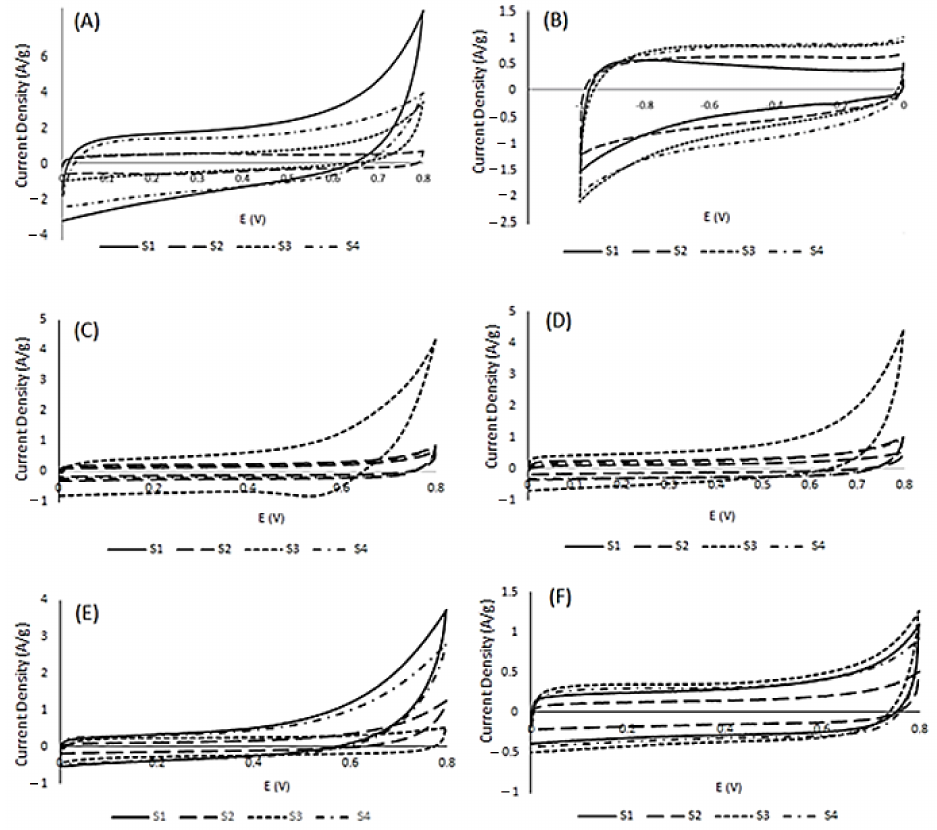
Figure 3. Cyclic voltammograms for S1–S4 in acidic ( A ), basic ( B ) and salt (KCl ( C ), KNO 3 ( D ), NaNO 3 ( E ) and NaCl ( F ) electrolyte at 10